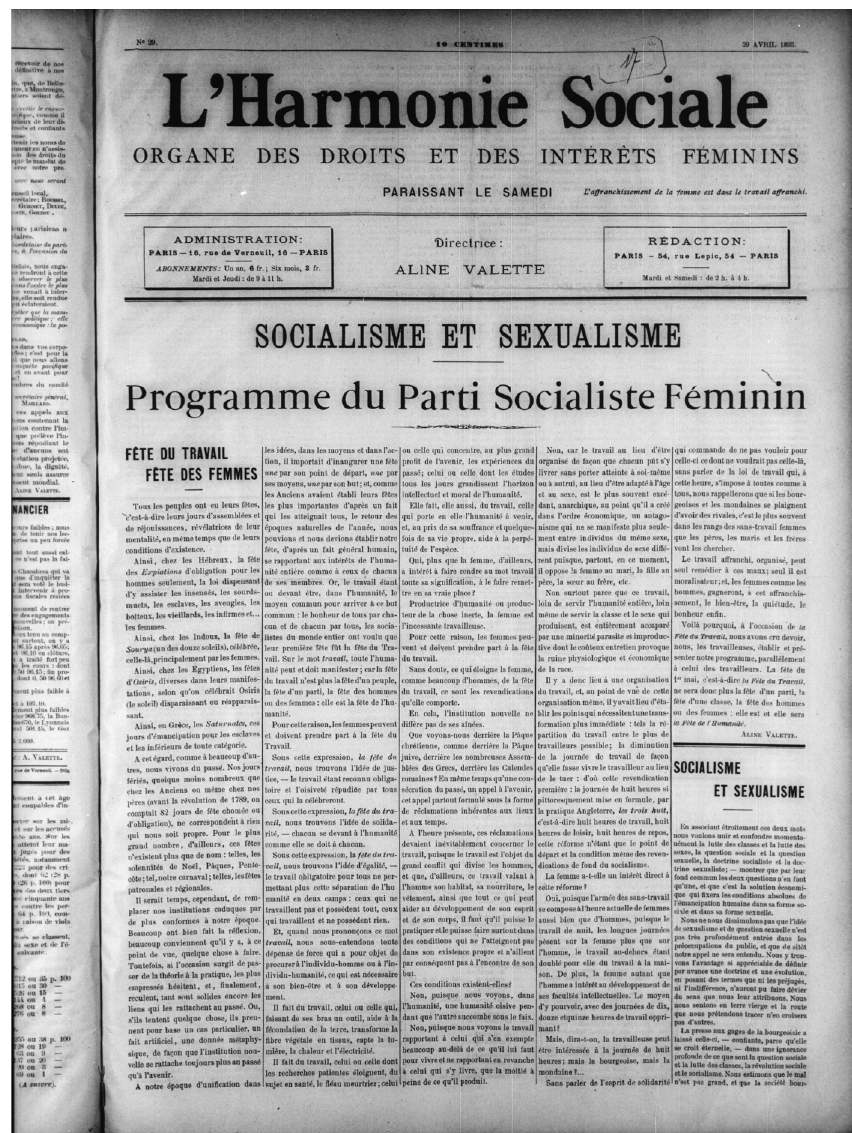
Fig. 2 ‘Socialisme et sexualisme’ on the front page of L’Harmonie sociale (29 April 1893). Bibliothèque Marguerite